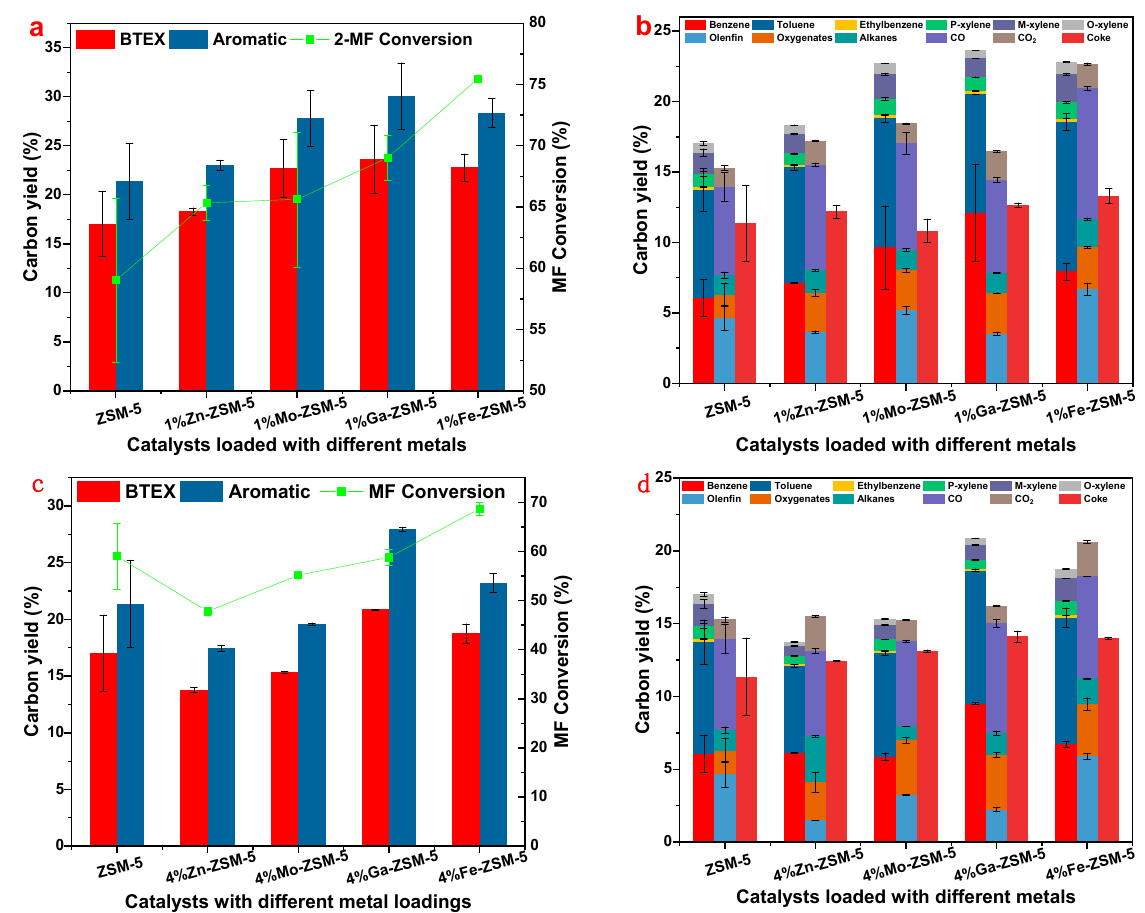
Figure 1. The effect of metal species on the product distribution from CFP of MF over metal-modified ZSM-5: ( a , c ) carbon yields of BTEX, aromatics, and MF conversion; ( b , d ) carbon yields of benzene, toluene, ethylbenzene, xylene, olefins, oxygenates, alkane, CO, CO 2 , and coke. Reaction conditions: 550 °C, WHSV: 4 h − 1 , carrier gas flow rate: 120 mL/min, reaction time: 15 min. 2.2. The Effect of Fe Loading on the Product Distribution from the CFP of MF over Fe-ZSM-5